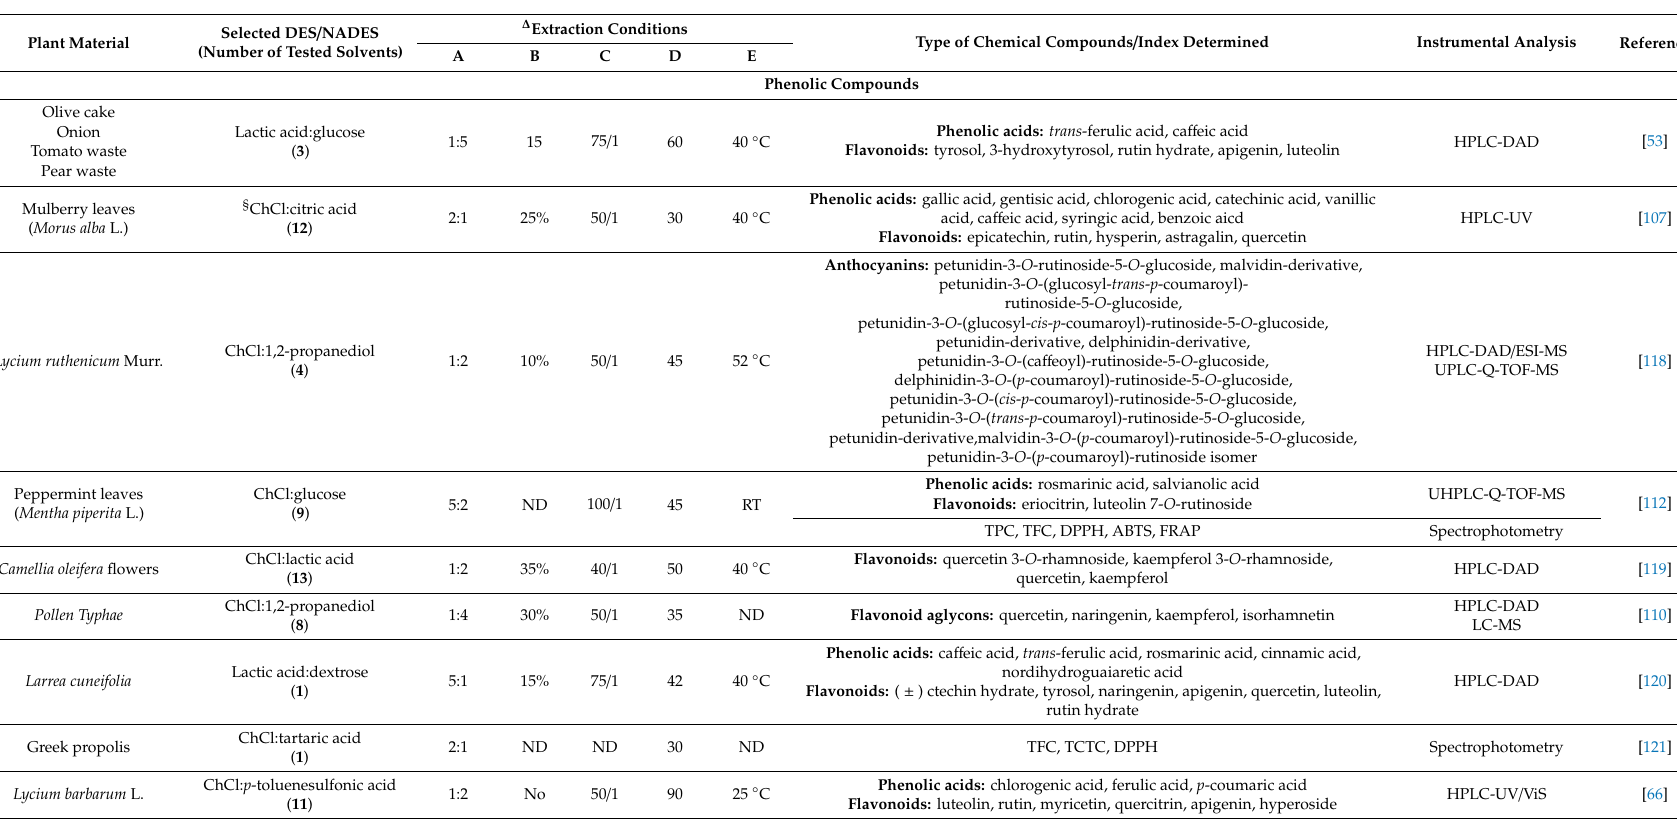
Table 1. Application of DES / NADES in combination with the ultrasound-assisted extraction (UAE) of bioactive compounds from the various plant material in the last three